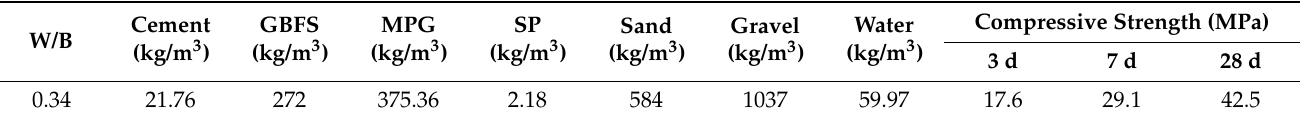
Table 2. Mix proportion of parathion gypsum slag cement concrete.